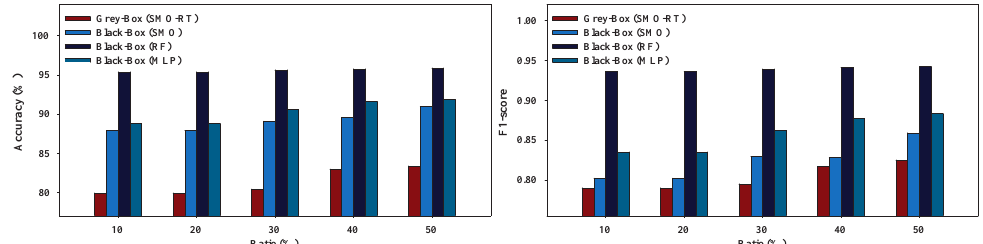
Figure 9. Box-plot with performance evaluation of Grey-Box and Black-Box models for EduDataA dataset.